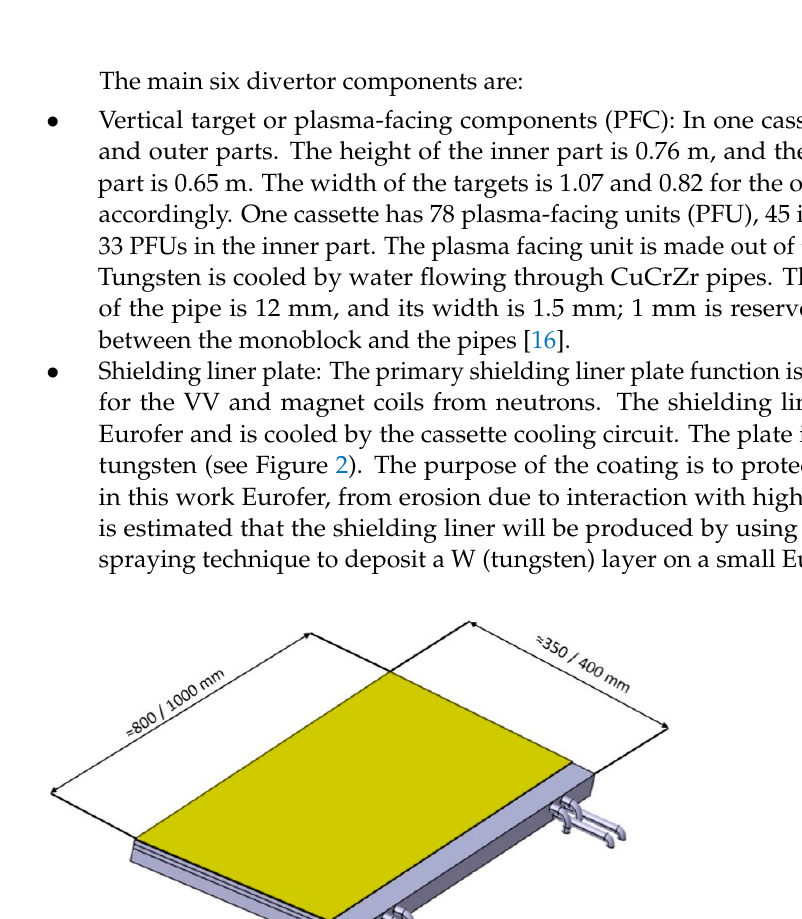
Figure 1. ( a ) Computer ‐ Aided Dsesign (CAD) model of 2019 DEMO divertor assembly, with the